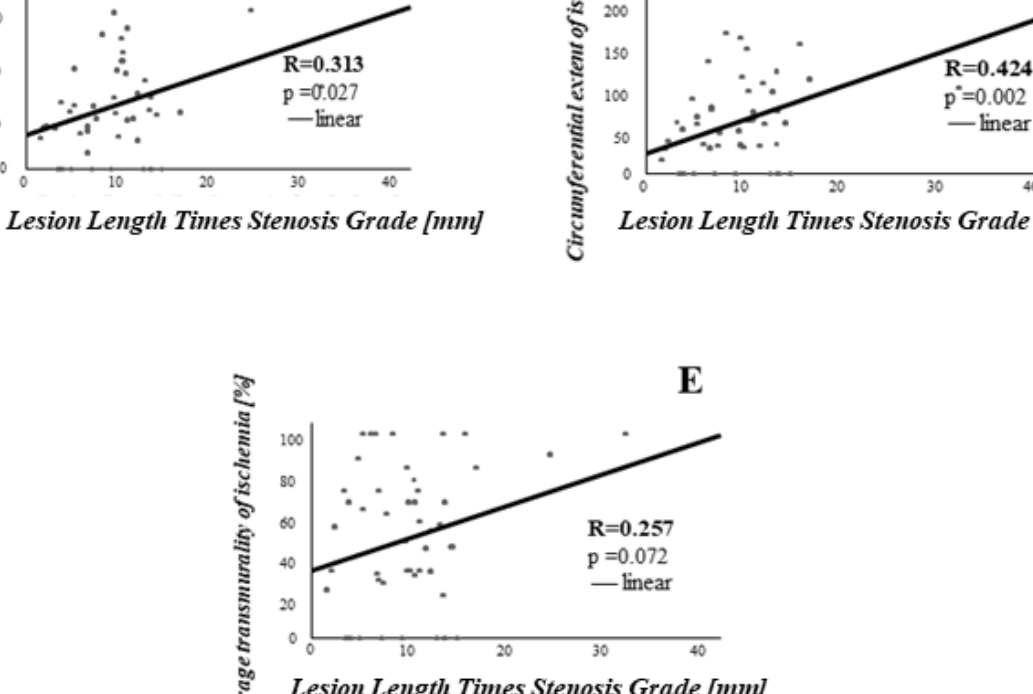
Figure 4. Lesion Length Times Stenosis Grade significantly correlates with extent of myocardial ischemia. On the X-axis, lesion length times stenosis grade ( A – E ) is shown. On the Y-axis are plotted various parameters assessing extent of myocardial ischemia.